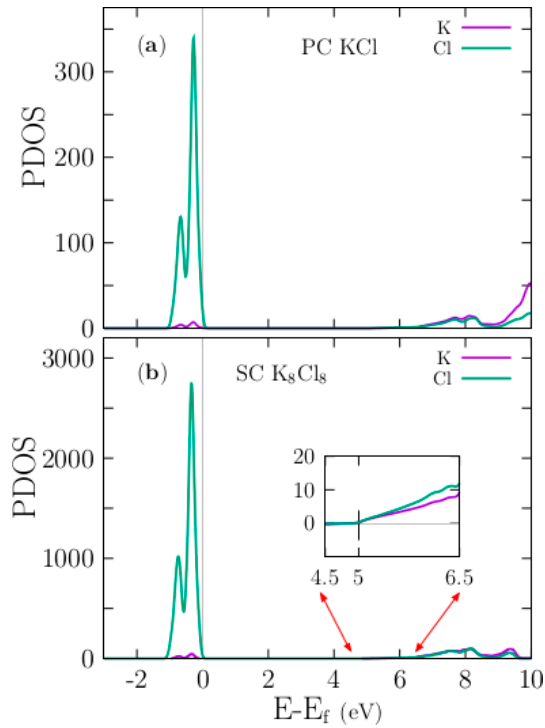
Figure 3. The upper panel ( a ) shows the Kohn–Sham projected density of states (PDOS) for the pristine PC for KCl. The lower panel ( b ) shows the PDOS for the pristine SC of K 8 Cl 8 . In both plots, the Cl-3p states dominate at the Fermi